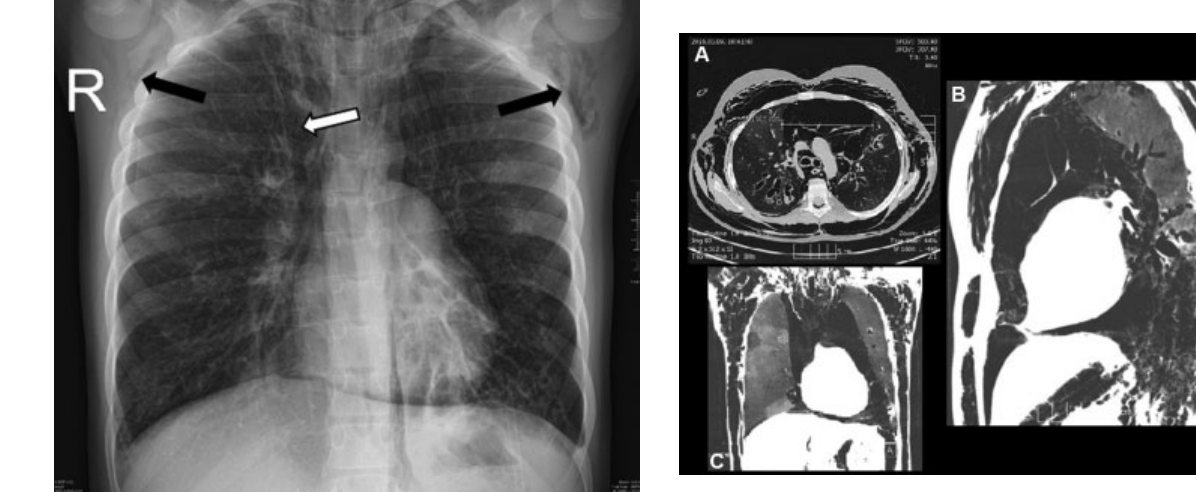
Fig. 2 Computed tomography scan (in the level of bifurcation) depicted an extensive subcutaneous emphysema and a huge pneu- momediastinum (diameter: 10.8cm): ( A ) Transverse, ( B ) sagittal, and ( C ) coronal section.